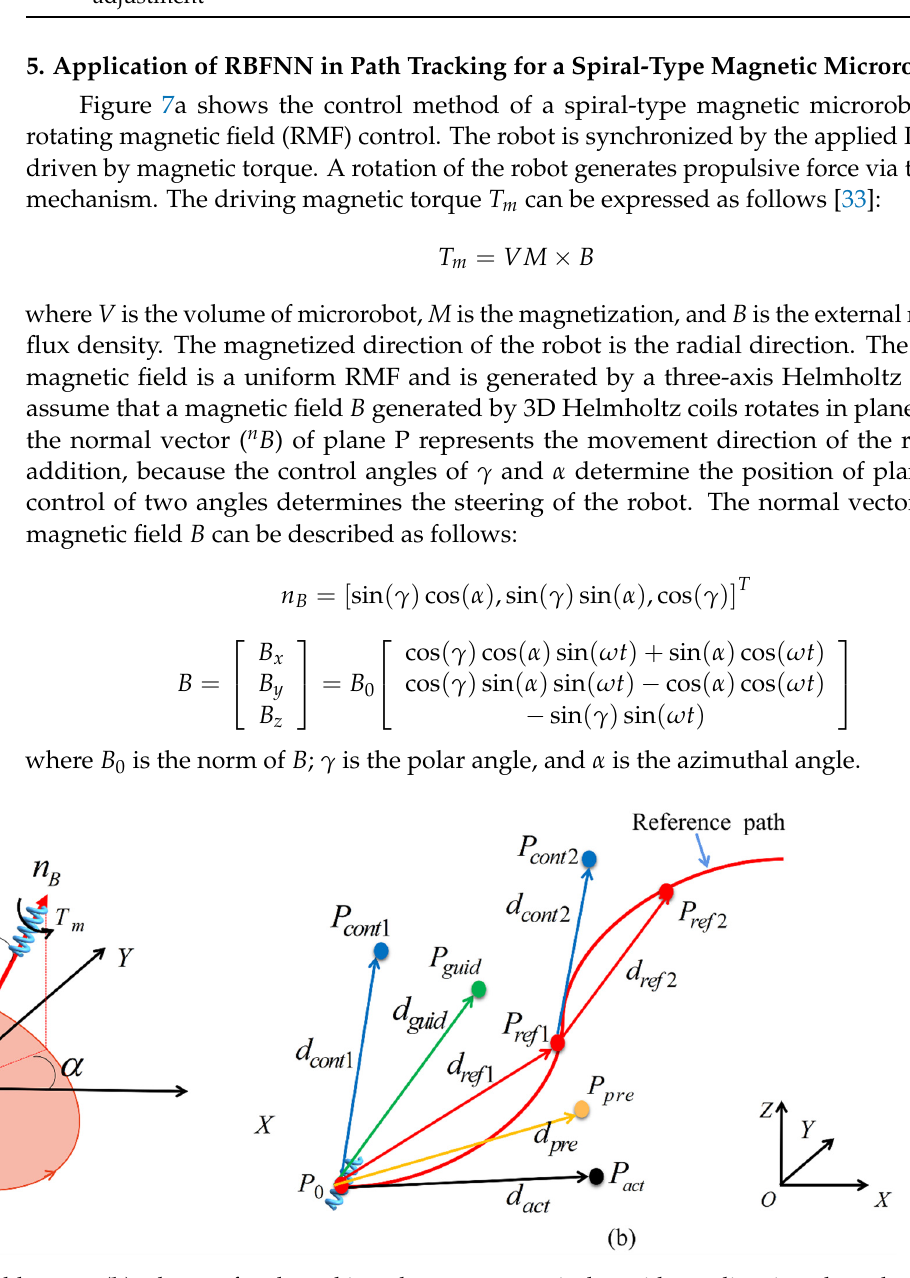
Figure 7. ( a ) Magnetic field vector; ( b ) scheme of path tracking: the green arrow is the reference direction, the red arrow is the desired direction, the yellow arrow is the predicted direction, the blue arrow is the control direction, and the black arrow is the actual